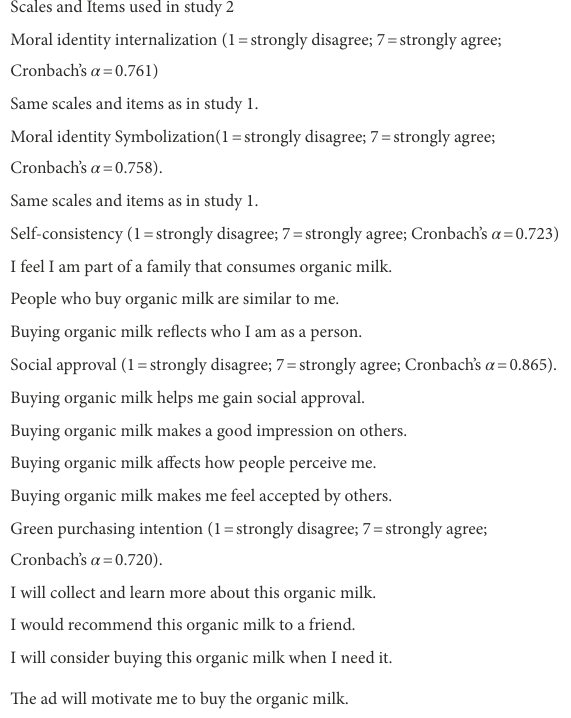
TABLE 3 Scales and Items used in study 2.